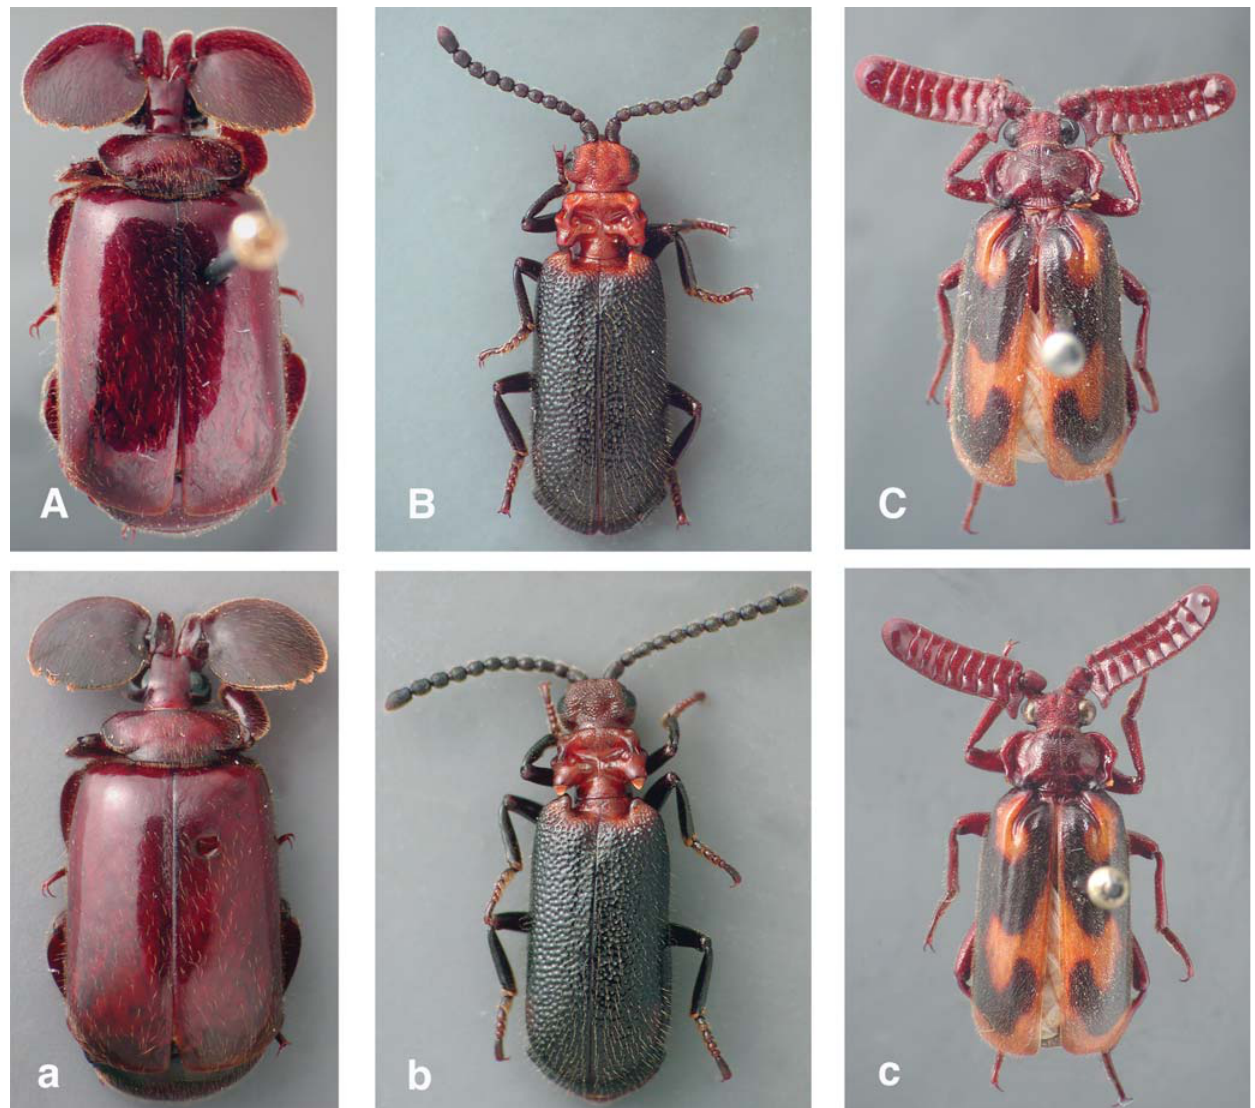
Figure 1. Samples pre-and post-extraction. Photographs of three beetle specimens before (A,B,C) and after (a,b,c) overnight treatment in the extraction buffer. The specimens are as follows: A/a Platyrhopalopsis mellei (collected in 1966), B/b Protopaussus sp. B (collected in 2002), C/c Heteropaussus hastatus (collected in 1980).